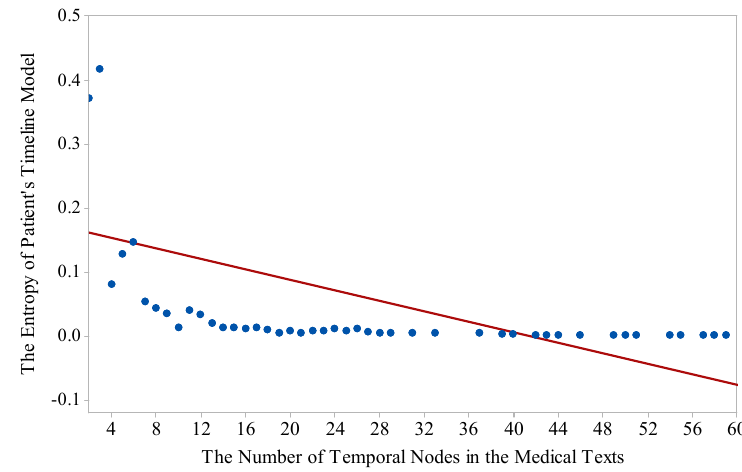
Figure 5. The changes of entropy with the increasing number of temporal nodes in EMR text.